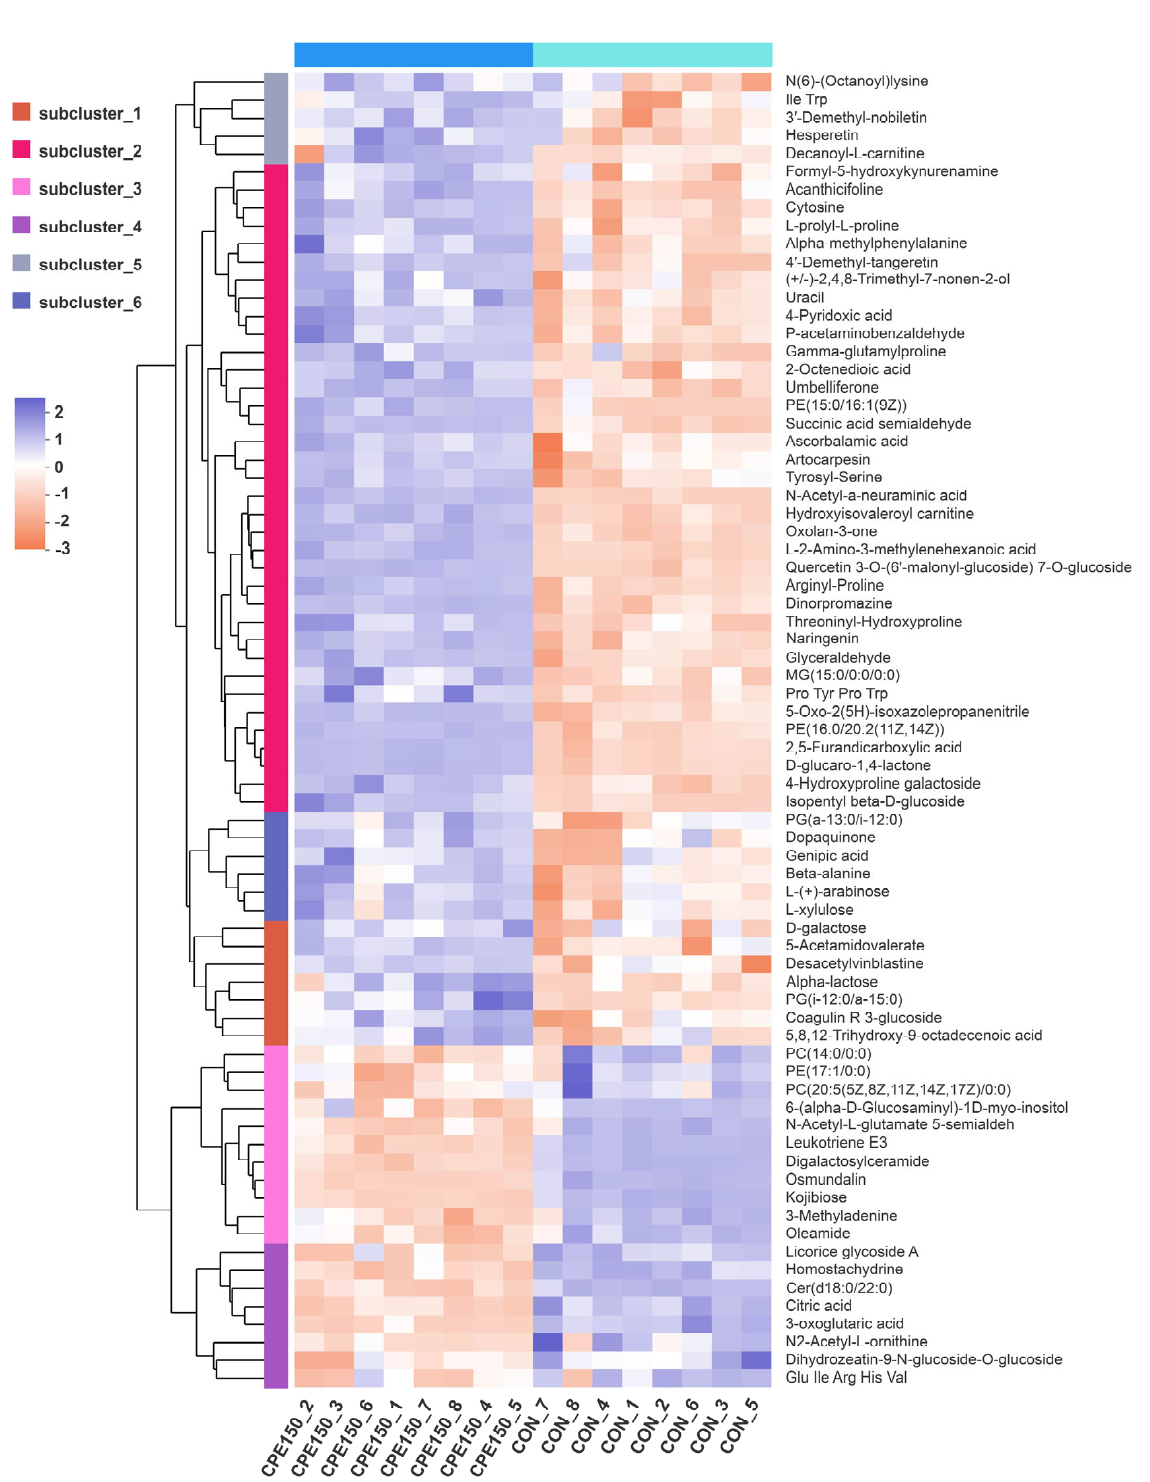
Figure 5. Clustering heatmap of differentially expressed metabolites between the milk of dairy cows fed the control diet (CON) and supplementary citrus peel extracts at 150 g/d (CPE150).